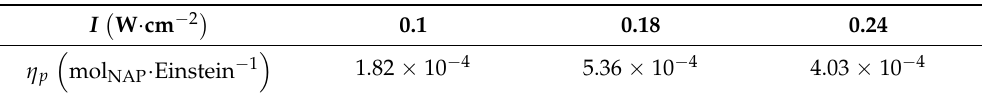
Table 2. Photonic efficiencies at different ca irradiances, calculated from the experimental values of NAP conversion in Figure 1 and the photons flow irradiated over the reactor window.